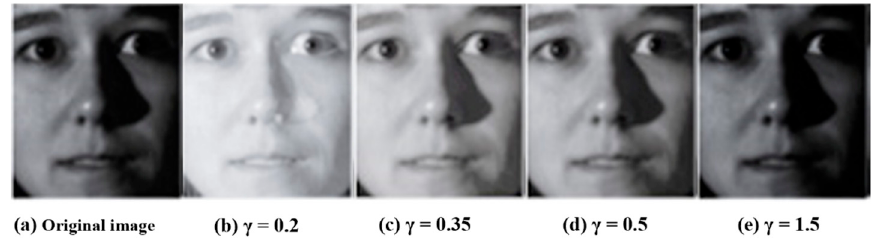
Figure 2. The gamma function curve with different values.